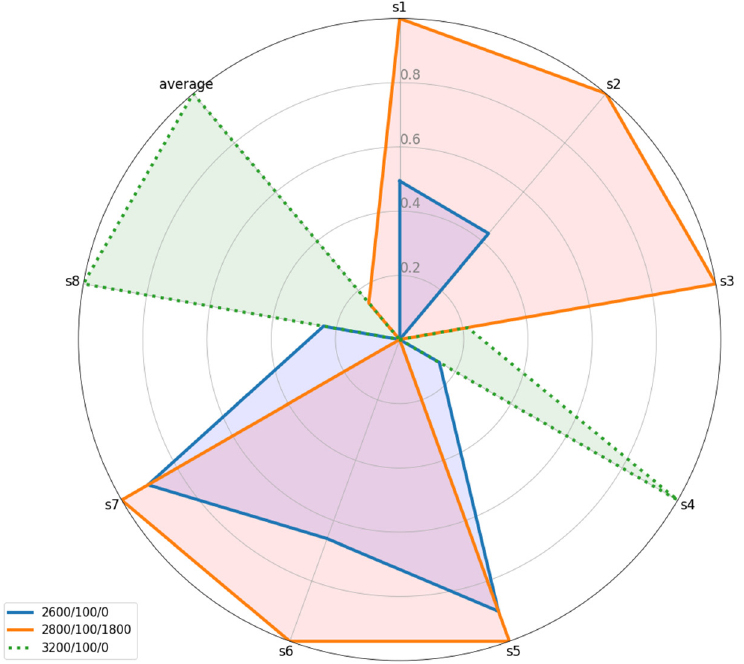
Figure 2. Cost by scenario of three example alternatives out of 250 alternatives total (Key: Each line corresponds to one of the 3 alternatives with various values of x 1 (m 3 /s flow threshold for triggering avulsion)/ x 2 (km location of diversion)/ x 3 (floodway size m 3 /s), as indicated in the legend. Each axis shows the alternative’s cost rank within a Table 2 scenario, in terms of its position relative to the least and most costly alternatives within that scenario, with 0% being least costly and 100% being most expensive. The exception is the average axis, which shows the average of those percentages across scenarios for each scenario).